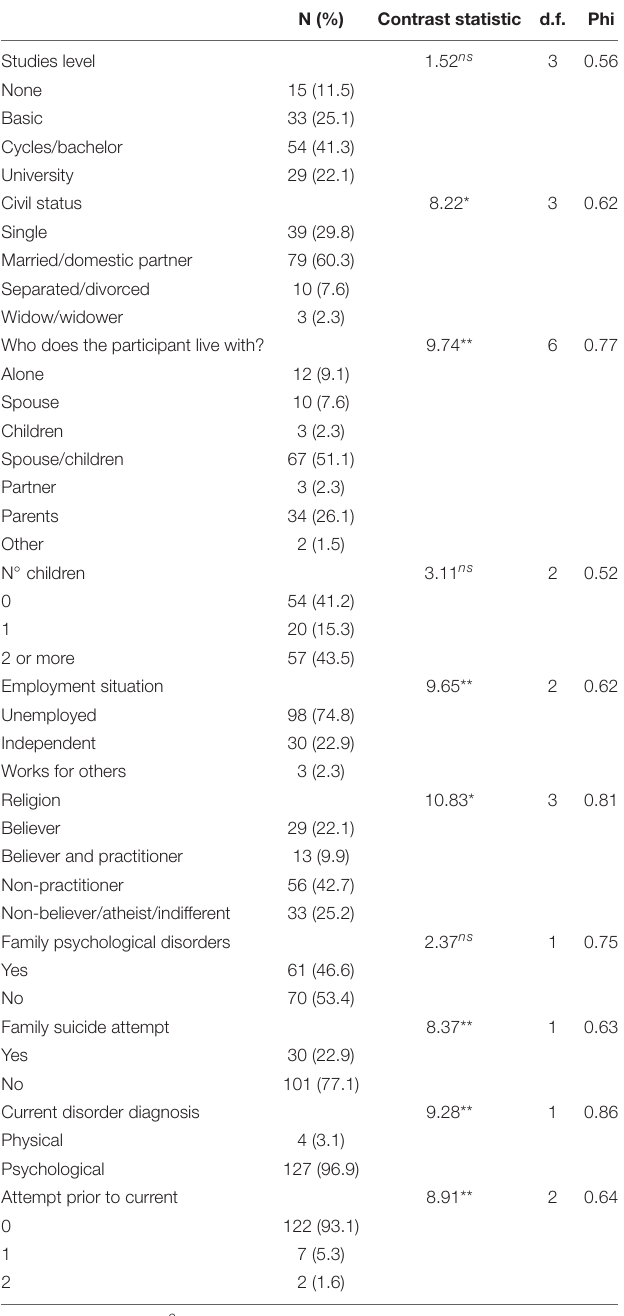
TABLE 1 | Summary of sociodemographic data of the sample ( N =